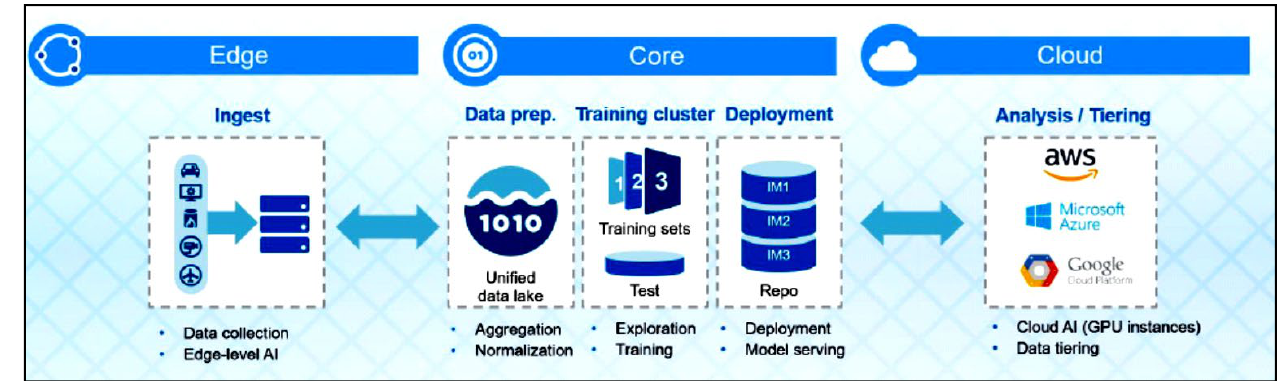
Figure 4. Edge Process to Core Cloud